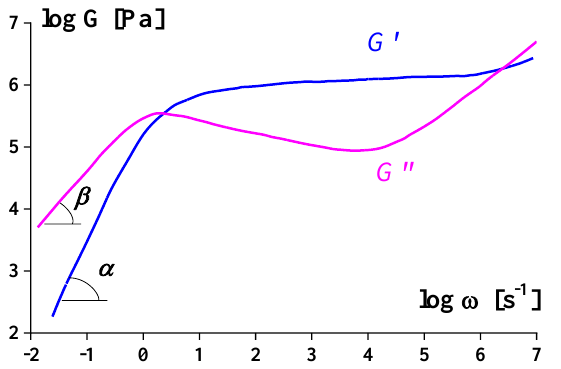
Figure 4. Typical frequency dependences of the components of the complex dynamic modulus for